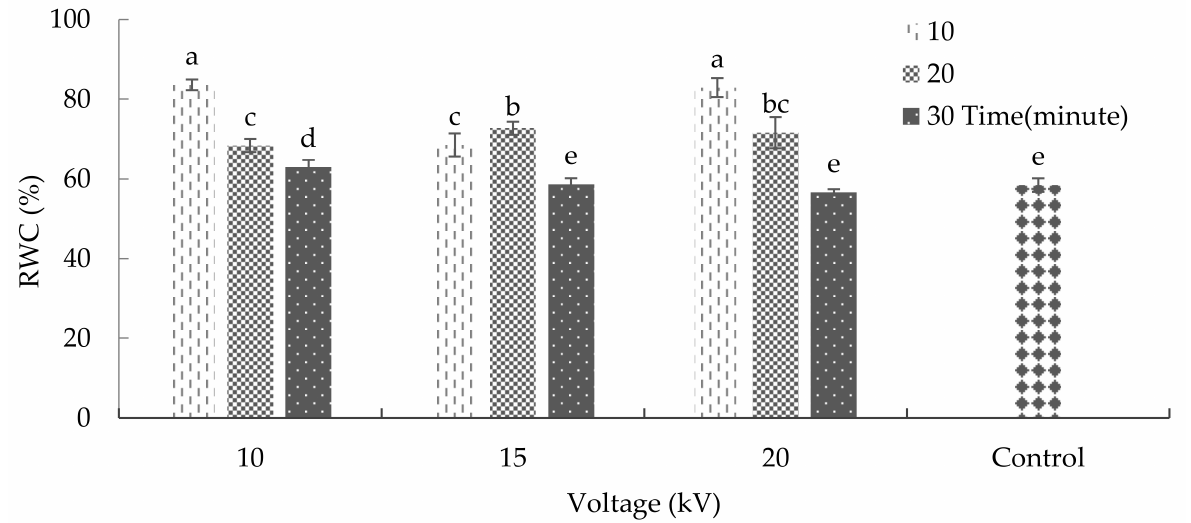
Figure 1. Plasma effects on the relative water content of basil. Error bars indicate standard error ( n = 3). Different lowercase letters denote statistical differences between treatment groups at the 5% level according to Duncan’s